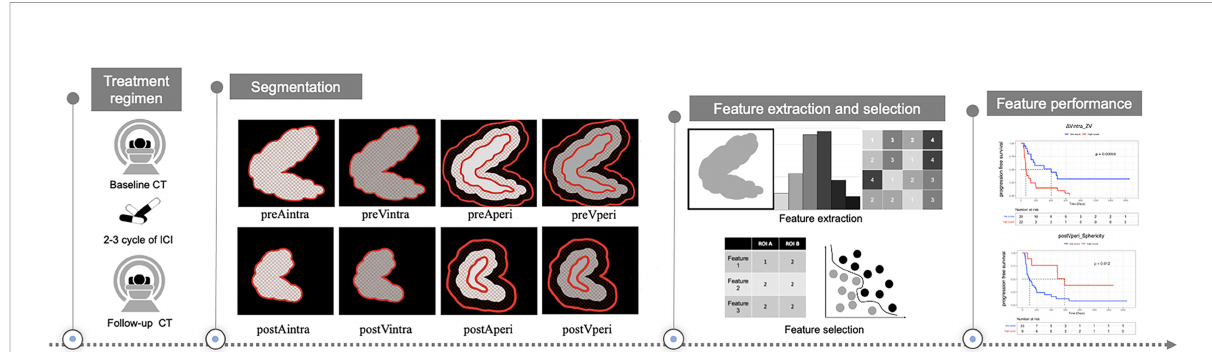
FIGURE 1 Study design for the evaluation of response prediction to immune checkpoint inhibitors in stage IV gastric cancer patients based on radiomics features. preAintra: intratumoral regions on baseline atrial phase; preVintra: intratumoral regions on baseline venous phase, preAperi: peritumoral regions on baseline atrial phase; preVperi: peritumoral regions on baseline venous phase; postAintra: intratumoral regions on follow-up atrial phase; postVintra: intratumoral regions on follow-up venous phase; postAperi: peritumoral regions on follow-up atrial phase; postVperi: peritumoral regions on follow-up venous